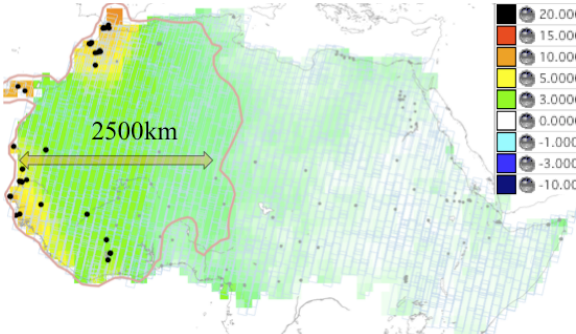
Fig. 3: Difference of planimetric location between two spatiotriangulations.